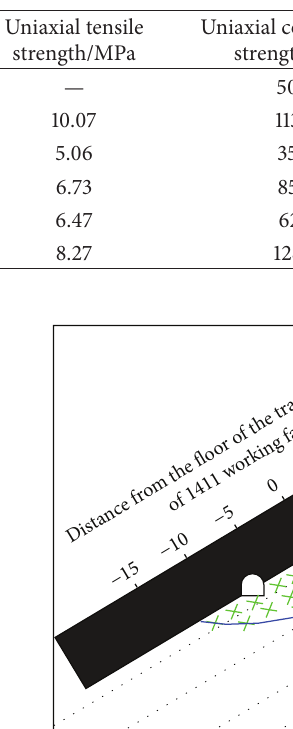
Table 2: Strata underlying the coal seam and its physical and mechanical parameters.